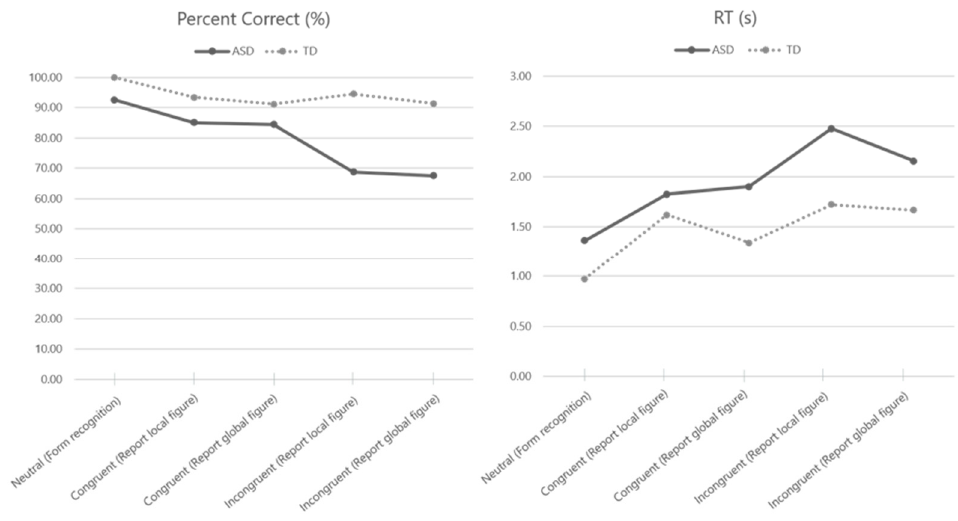
Figure 2. Plot for percent correct (%) and reaction time(s) in each condition among children with ASD and TD. Table 4. Group differences between children with ASD and TD in each condition.